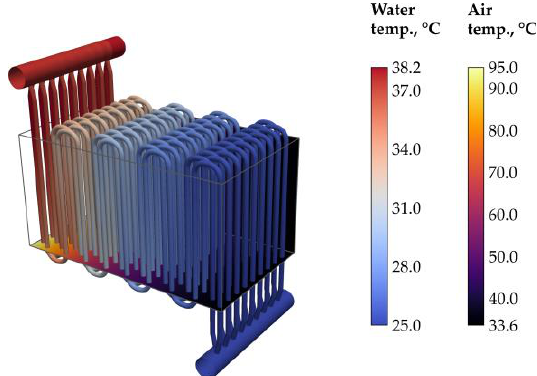
Figure 8. Energies 2020 , 12 , x FOR PEER REVIEW